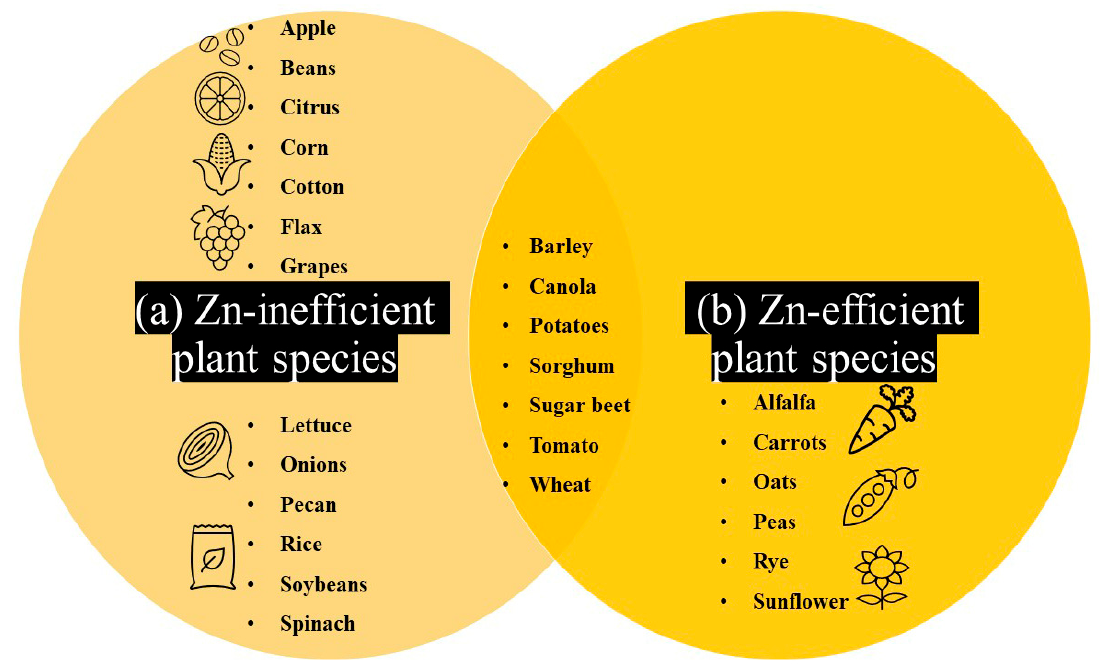
Figure 2. Venn diagram showing the Zn-inefficient plant species ( a ) and Zn-efficient plant species ( b ); overlap area: mildly Zn-efficient plant species.